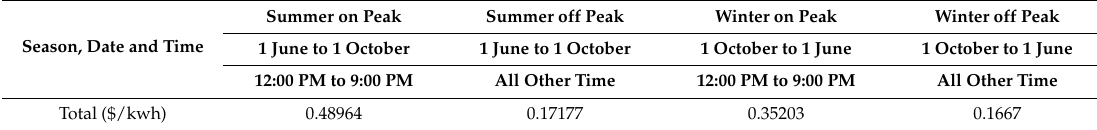
Table 3. Florida Light and Power (FPL) Time of Use Rate.